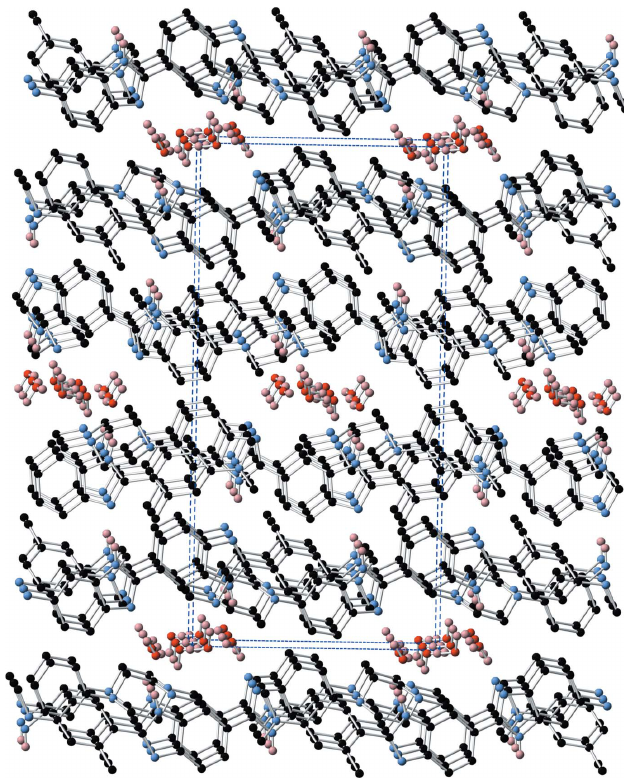
Figure 7 Three-dimensional hydrogen-bonded network in (1) (cid:2) 2H 2